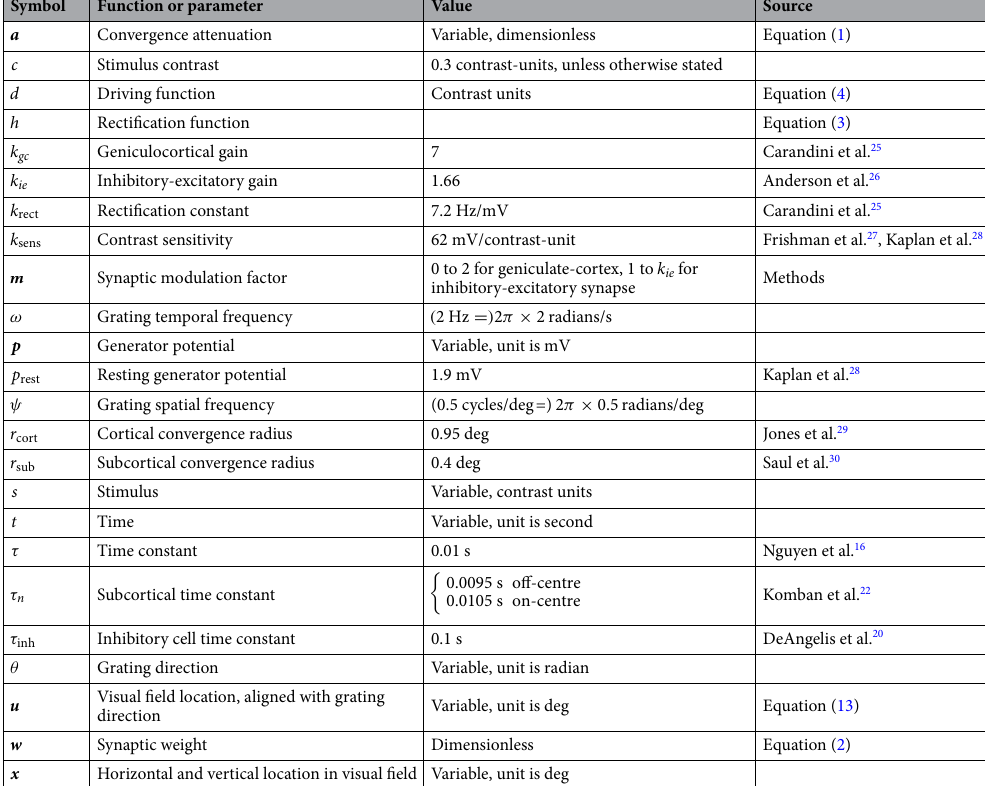
Table 1. Glossary of symbols and model parameters. The table show the symbols used for model parameters and functions, parameter values where relevant, and the equations or published papers used to calculate parameter values. Bold symbols represent vectors and